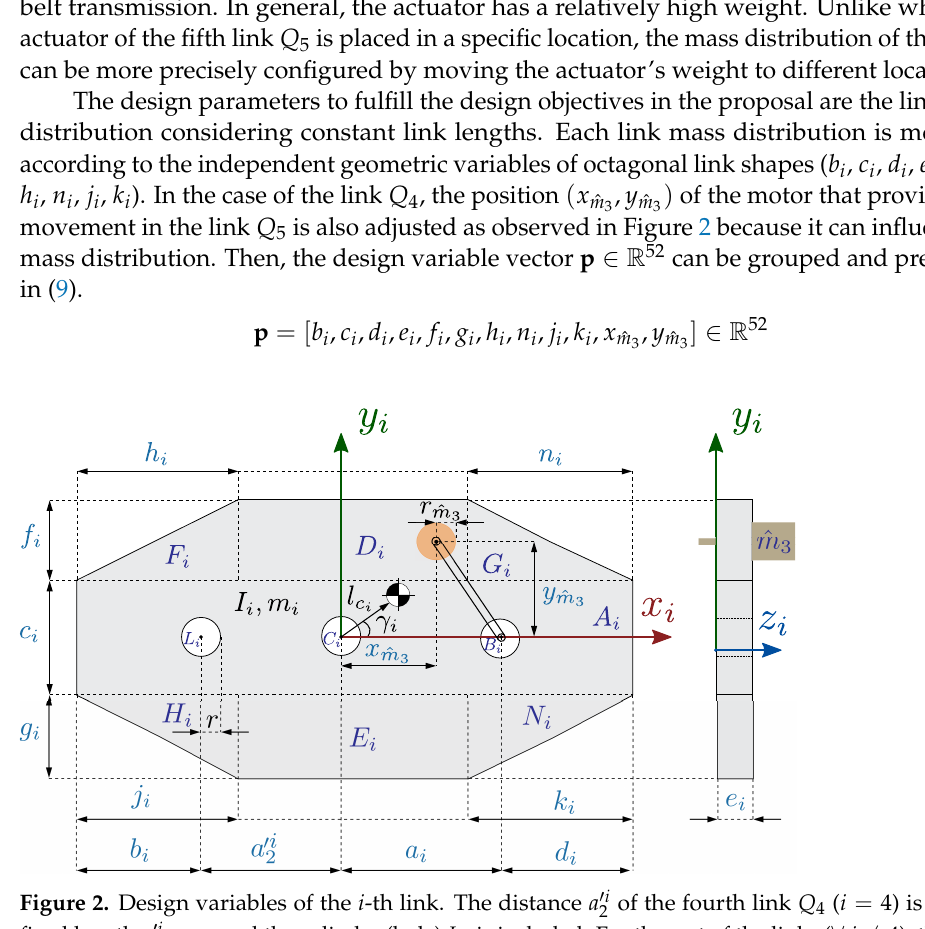
of the fourth link Q 4 ( i = 4) is set as a 2 ∀ i (cid:54) = 4), the fixed ( x ) are removed (the length, the hole, ˆ m 3 , y ˆ m 3